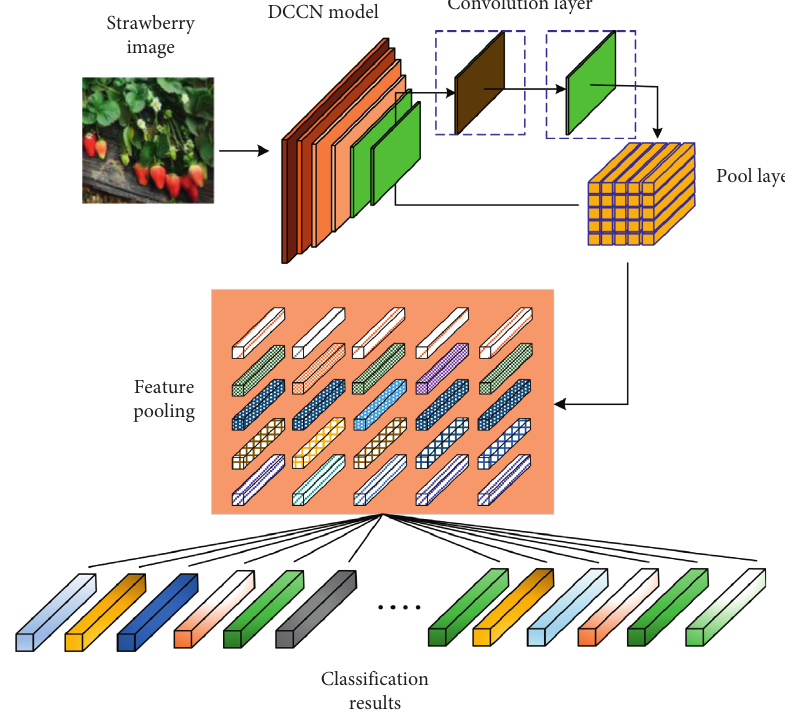
Figure 2: Model structure of deep convolution neural